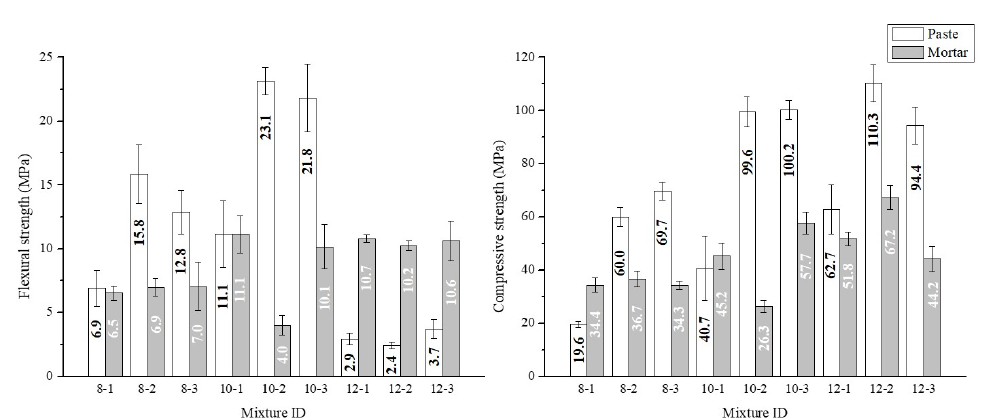
Figure 6. Mechanical properties of alkali-activated specimens at 7 days of